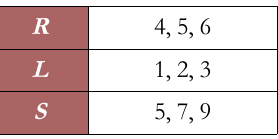
Table 2. Parameters of the experiment